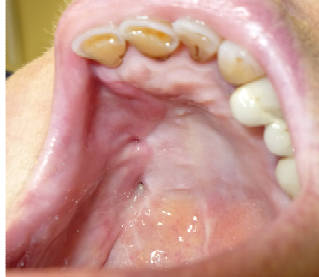
Figure 6. Palatal plate detail.